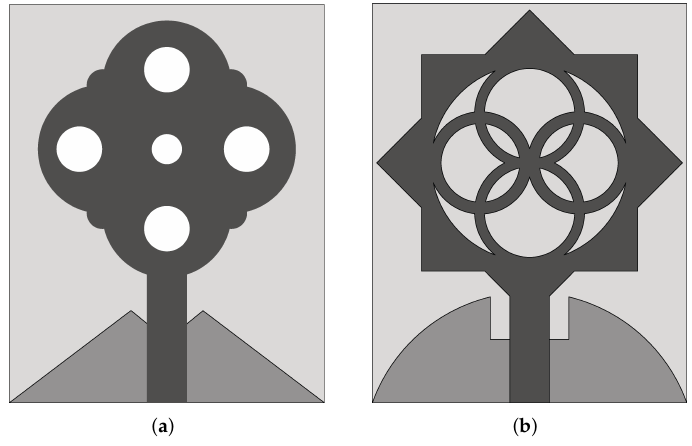
Figure 22. Miniaturized fractal antenna designs ( a ) Sierpinski gasket ( b ) rings inscribed hexagonal patch (redrawn from [86]). Dark gray top metal face, medium gray bottom metal face, and light gray dielectric substrate.